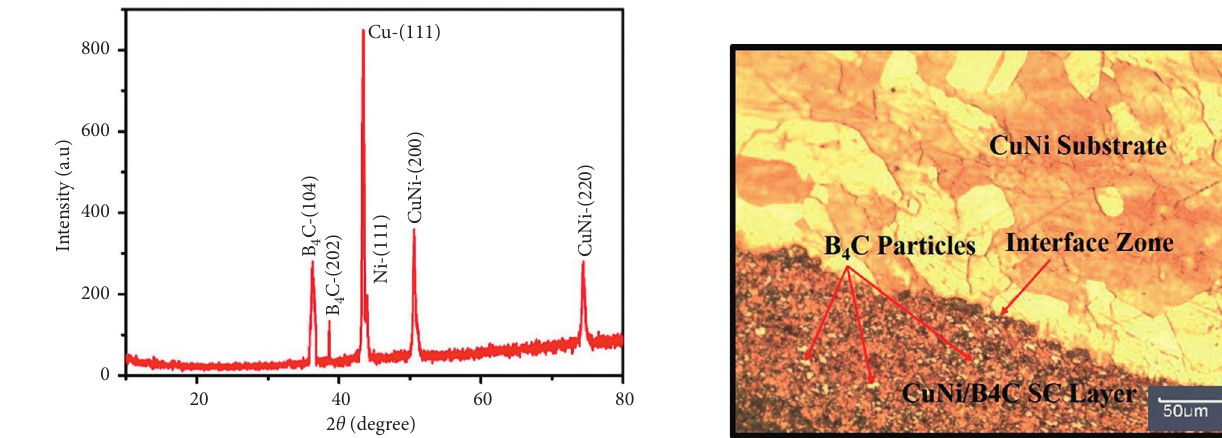
4 C particle in CuNi alloy.